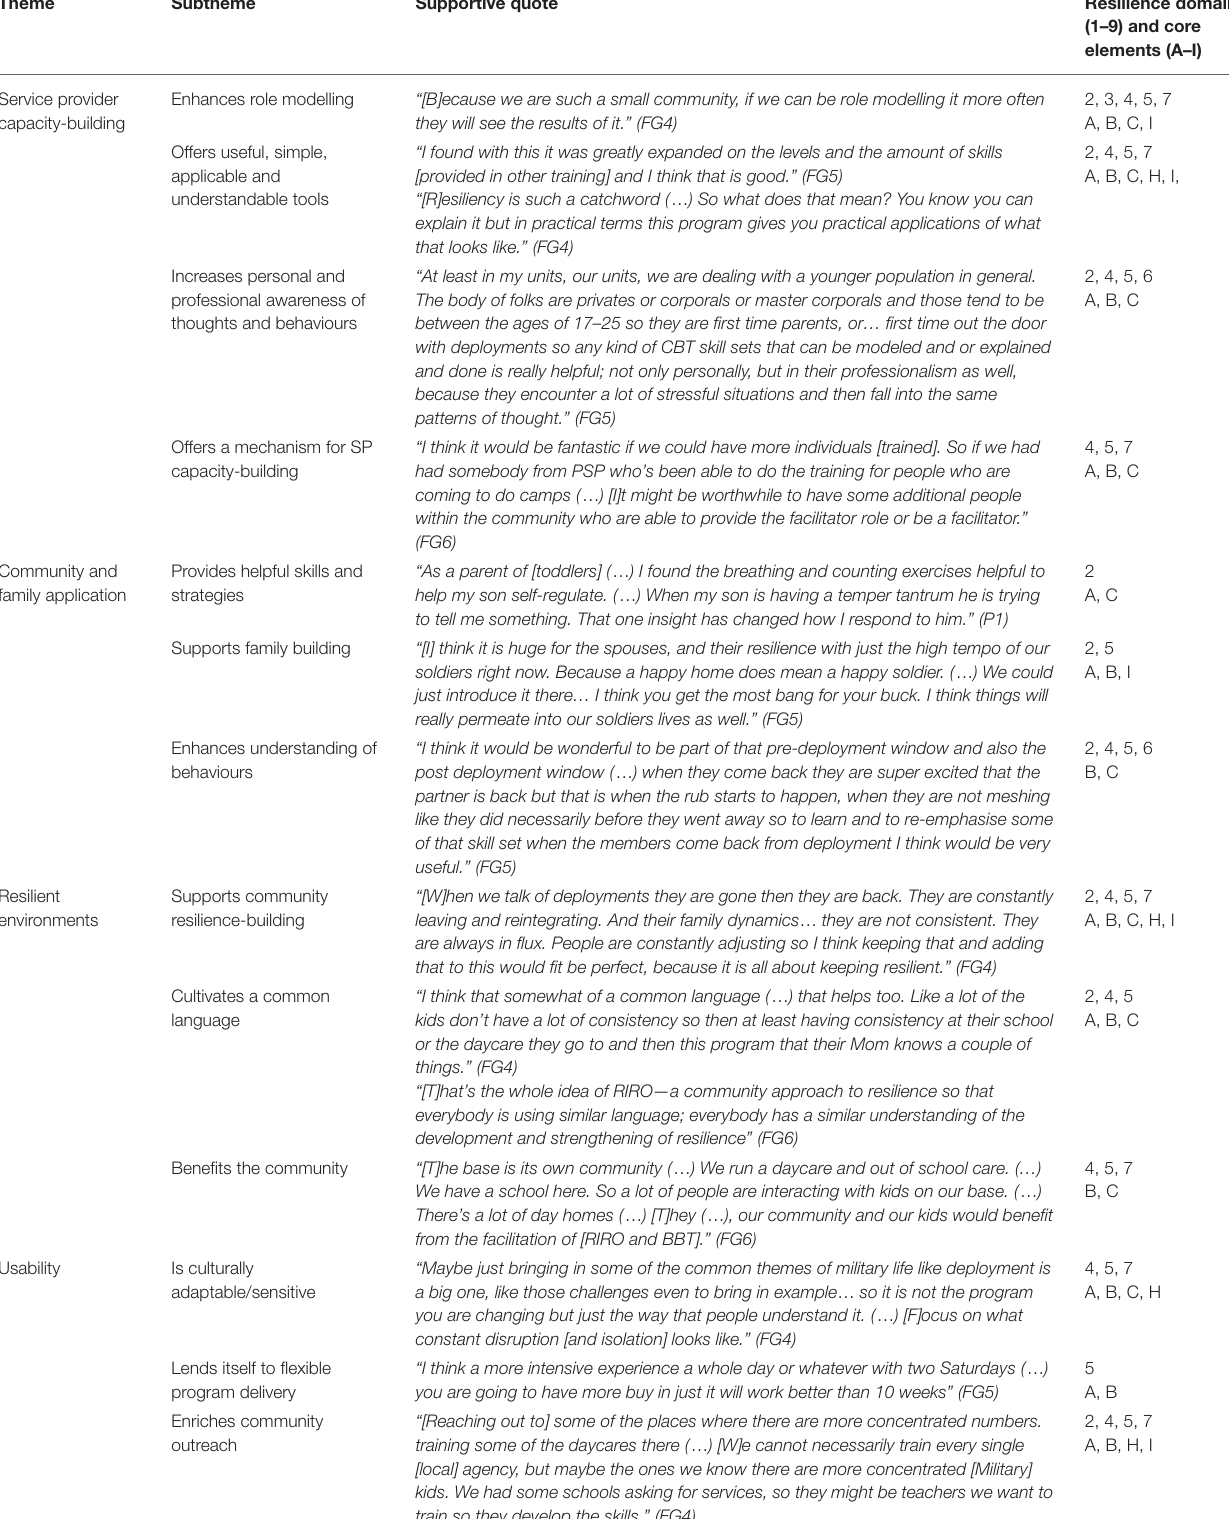
TABLE 4 | Themes, subthemes, and supportive quotes and resilience domains/core elements. Theme Subtheme Supportive quote Resilience domains